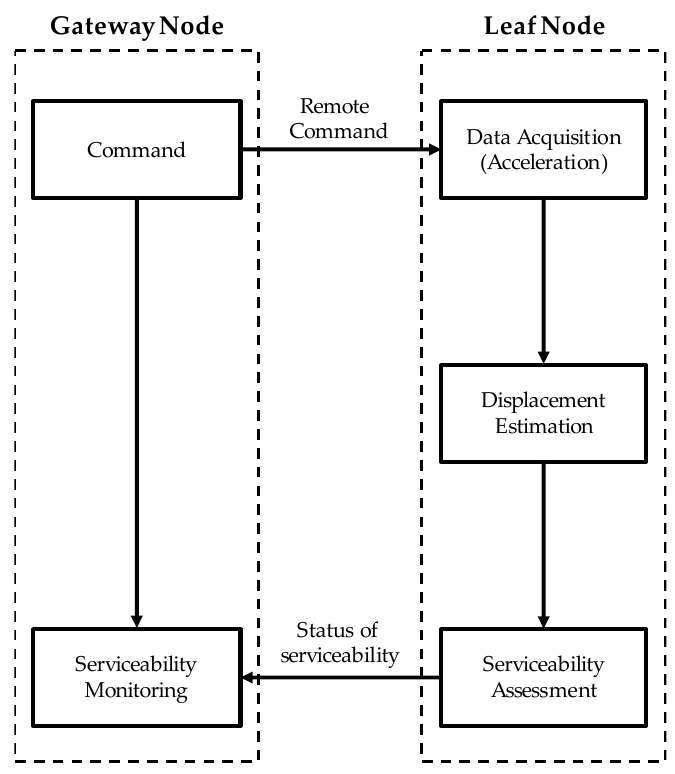
Figure 3. Flowchart for automated real-time cable serviceability assessment .